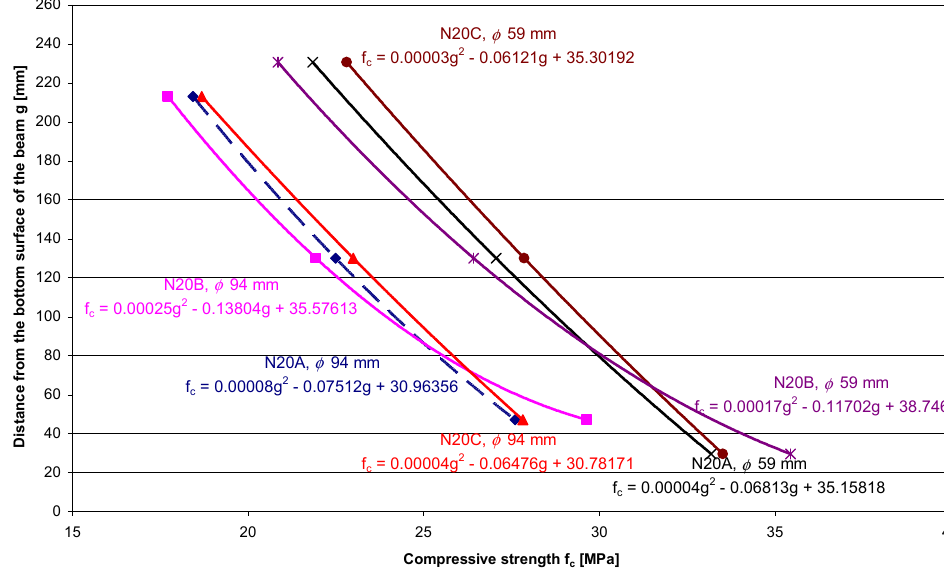
Figure 5. Distribution of the compressive strength of the 20 MPa concrete, which was determined across the height of the core samples with diameters of 59 mm and 94 mm.